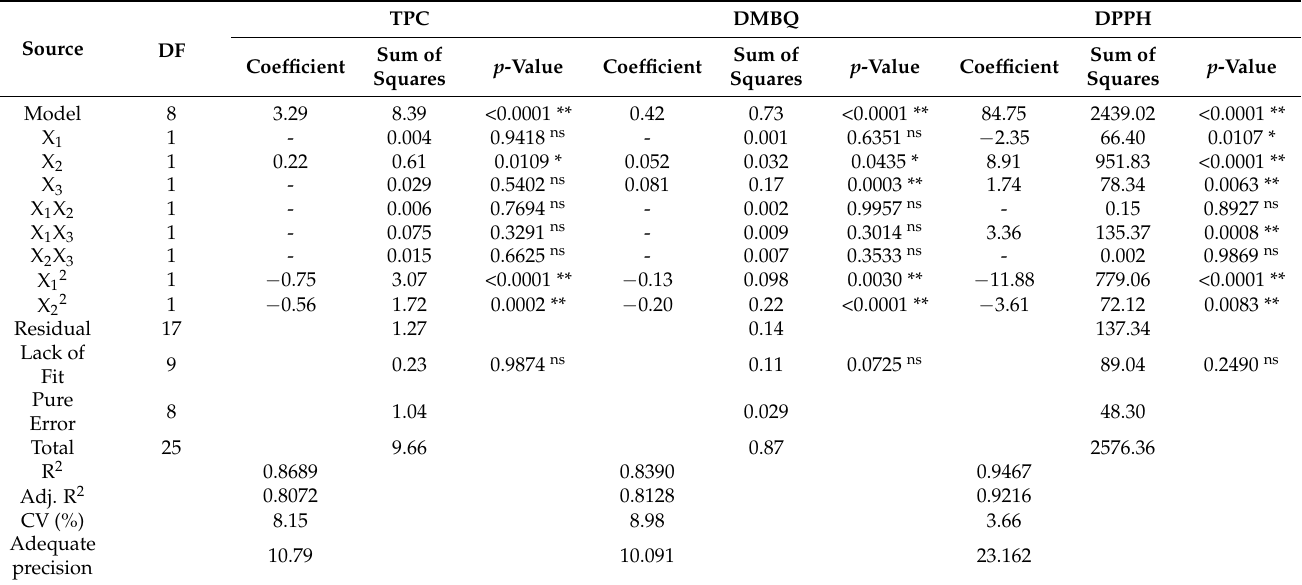
Table 2. Analysis of variance describing the effect of the different fermentation variables on the response variables (TPC, DMBQ, and DPPH) as linear, quadratic, and interactive terms and the coefficients for the predicted